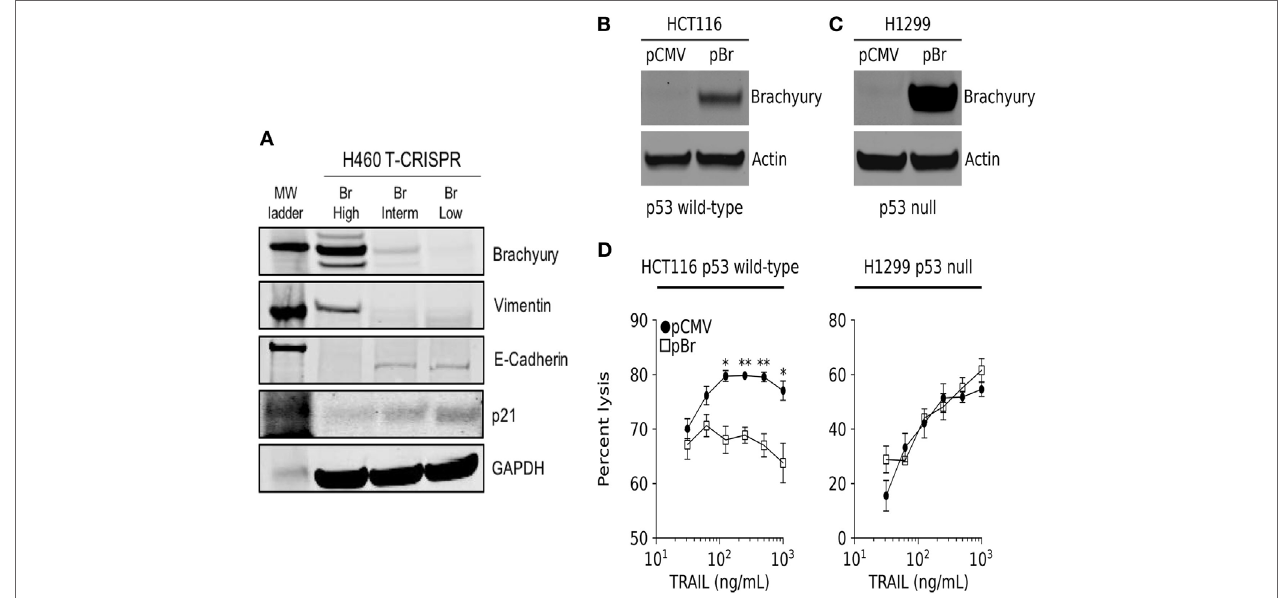
FigUre 2 | Brachyury drives resistance to TNF-related apoptosis-inducing ligand (TRAIL) in cells expressing a wild-type p53 gene. (a) Western blot analysis of brachyury, vimentin, E-cadherin, and p21 in H460 clones generated via the CRISPR/Cas9 system. (B,c) Western blot analysis of brachyury expression in HCT116 and H1229 cells, respectively, stably transfected with either a control or brachyury-encoding (pBr) plasmid. (D) The impact of brachyury expression on the sensitivity of HCT116 (left panel) and H1229 (right panel) to lysis by a range of TRAIL doses.